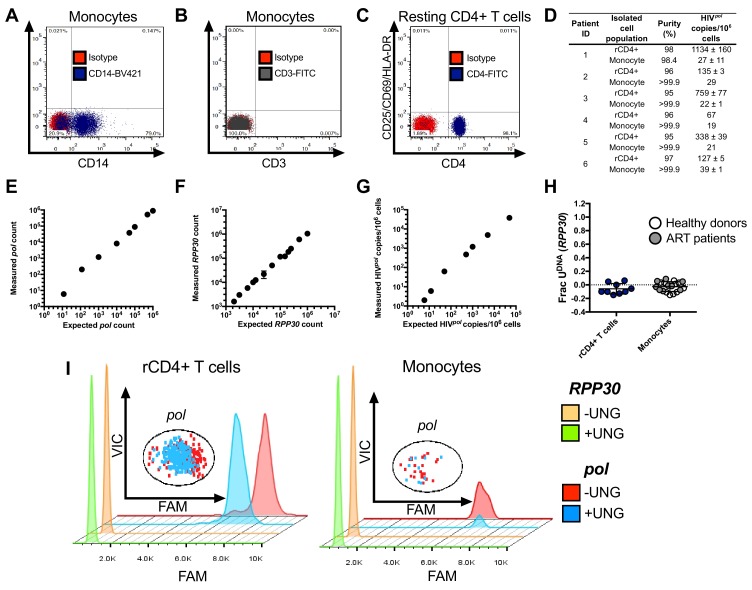
Purity and detection of HIV DNA in isolated cell populations from ART suppressed individuals.Resting CD4+ (rCD4+) T cells and monocytes were isolated from six ART suppressed individuals by negative selection. The results for donor 1 are shown in the figure panels. (A) Monocytes were stained for the specific monocyte markers CD14 and CD16. (B) The purity of the monocyte preparations was determined by negative staining for the T cell marker CD3. (C) To determine if the purified resting CD4+ T cells contained contaminating activated CD4+ T cells, we stained for CD4 and the activation markers CD25/CD69/HLA-DR. (D) The purity of the purified monocyte and rCD4 cells from each patient is indicated. The HIVpolcopies were determined by ddPCR and are expressed as an average and standard deviation (SD). When possible, two or three independent ddPCR measurements were taken. (E) NL4.3 plasmid was serially diluted over 100,000-fold to evaluate the detection limit of the ddPCR assay for HIV pol. (F) Dilution series of human genomic DNA with measurement of the RPP30 copy number by ddPCR. This series was used to determine the load limit for total DNA that can be accurately measured in a ddPCR reaction. (G) Measurement by ddPCR of HIV pol copy number in a background of genomic DNA obtained from 250,000 uninfected PBMCs. (H) Uracils are not detected in genomic DNA (RPP30 gene) of uninfected monocytes or T cells. Using RPP30 primers, Ex-ddPCR was performed on genomic DNA isolated from monocytes of healthy donors (open circles) or ART patients (gray circle) as well as rCD4+ T cells from ART patients. (I) Ex-ddPCR was used to determine that uracil is only found in HIV DNA isolated from monocytes and not rCD4+ T cells of HIV-infected patients. The shown data are for donor ID 2 (Supplementary file 4). For visualization, the histograms for the RPP30 Ex-ddPCR data have been down scaled by a factor of ~104 to facilitate comparison with the low abundance pol positive droplets. The insets show the raw scatter plots of the pol positive droplets that were used to generate corresponding histograms for each isolated cell population. The pol-positive droplets for the ddPCR and Ex-ddPCR experiments are shown in red and blue, respectively. The histograms for the pol-positive droplets follow the same color key. Number of experimental repetitions (n = 2–9) and errors are reported as mean ± SD.